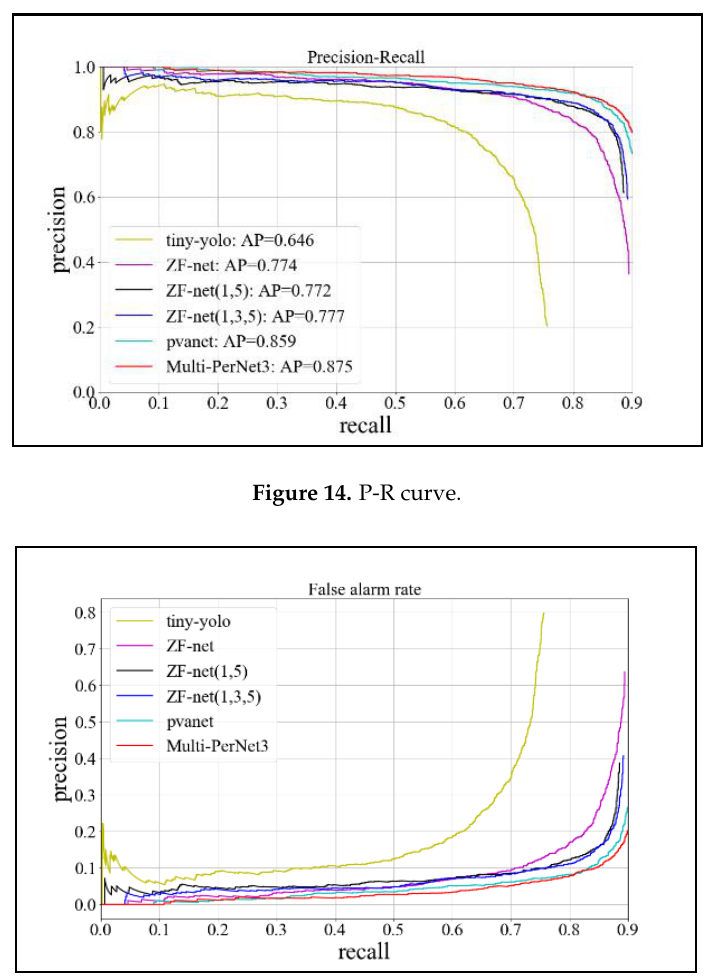
Figure 13. Loss curve of detector training process.